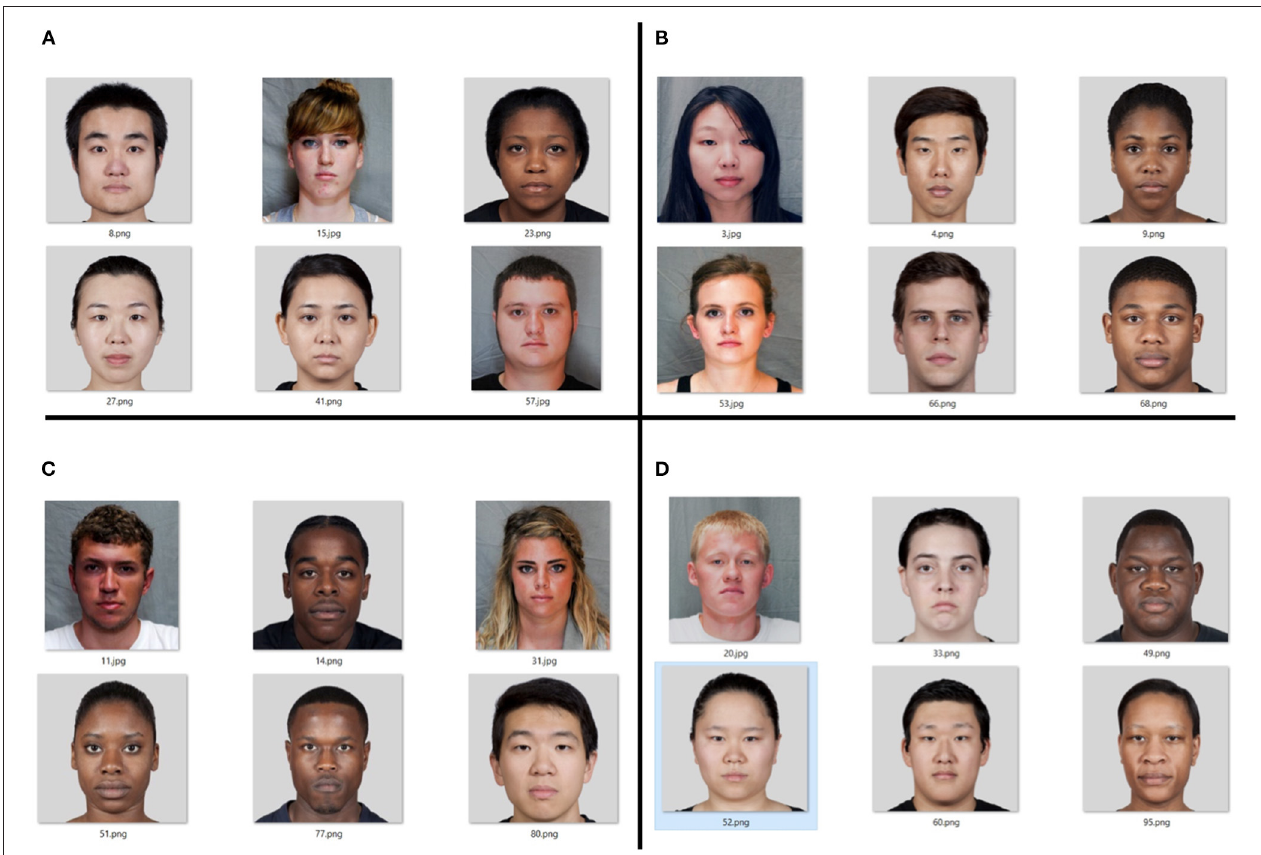
FIGURE 1 | A set of photos selected for future research, divided into groups: (A) low attractiveness and high confidence, (B) high attractiveness and high confidence, (C) high attractiveness and low confidence, (D) low attractiveness and low trust. Photos taken from the following databases: DEFSS (Meuwissen et al., 2017) and MR2 ( Strohminger et al.,